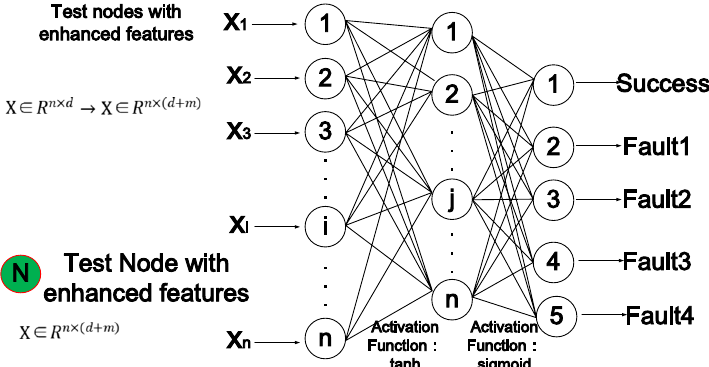
Fig. 7 Classification on test nodes with enhanced